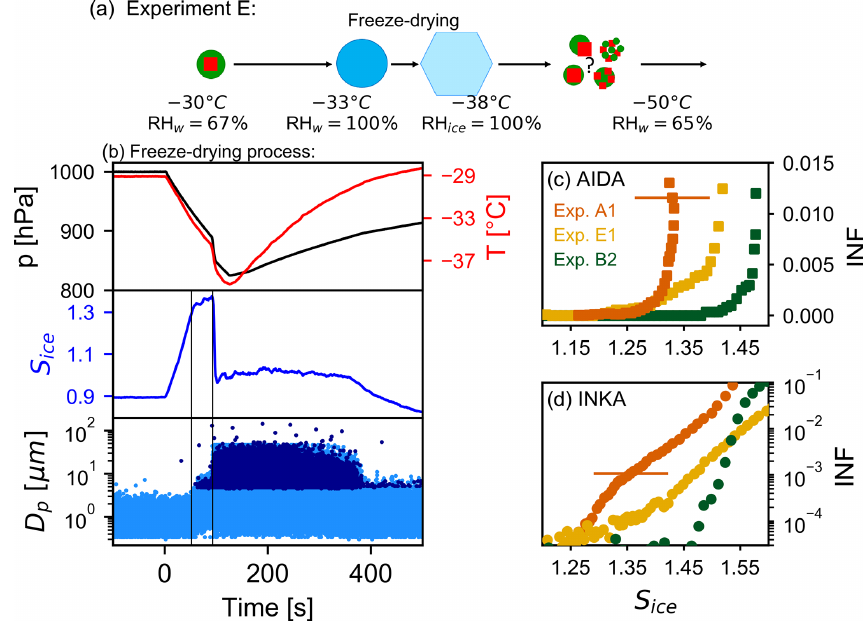
Figure 8. Results for the freeze-drying experiment (experiment E1). (a) Scheme of the freeze-drying process together with the possible phase state and morphology of the particles during the experiment. (b) Time series of the AIDA data during the freeze-drying process. Upper panel: pressure and temperature inside the AIDA chamber (black and red traces). Middle panel: saturation ratio with respect to ice (blue trace). Lower panel: single particle data from the welas optical particle counters (OPC1 and OPC 2) – each dot corresponds to an aerosol particle, droplet, or ice crystal at the corresponding size. Panels (c) and (d) show the ice-nucleating fraction as function of the saturation ratio with respect to ice measured by AIDA and INKA. Data for pure AS crystals are reported in orange (experiment A1), unprocessed AS crystals with thick SOM coating in green (experiment B2), and freeze-dried SOM-coated AS crystals in yellow (experiment E1). Note the different scale in panels (c) and (d)